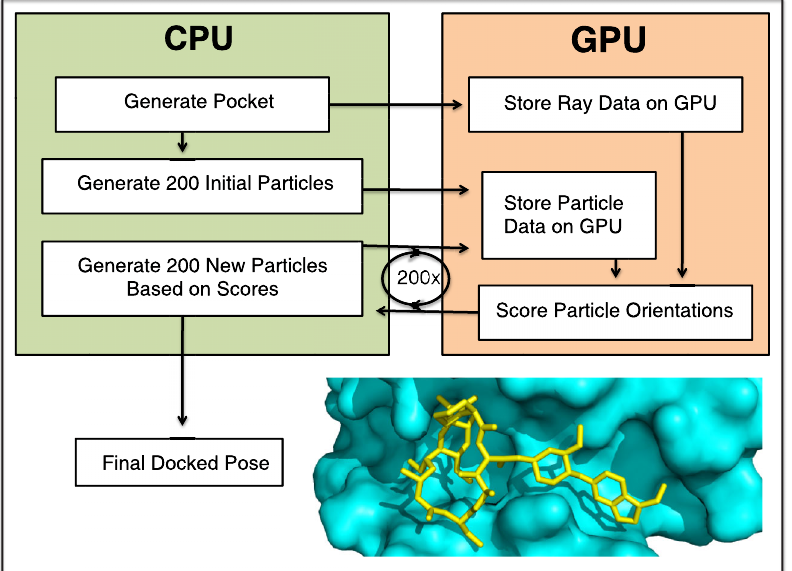
Figure 3. Control flow for GPU-enabled DARC. Control begins on the CPU. The CPU generates the pocket and casts rays at the protein surface, then stores this information on the GPU. The CPU generates 200 ‘‘particles’’ (independent initial ligand orientations to be used in the optimization) and passes each of these docked poses to the GPU. The GPU evaluates the DARC score of each docked pose, and passes these back to the CPU. The CPU uses these scores to update the docked poses accordingly, then sends the new poses to the GPU. This process is repeated 200 times, and the best-scoring particle is reported.